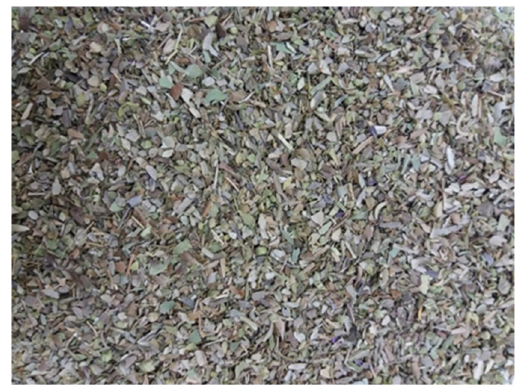
Figure 7. Dried oregano herb.